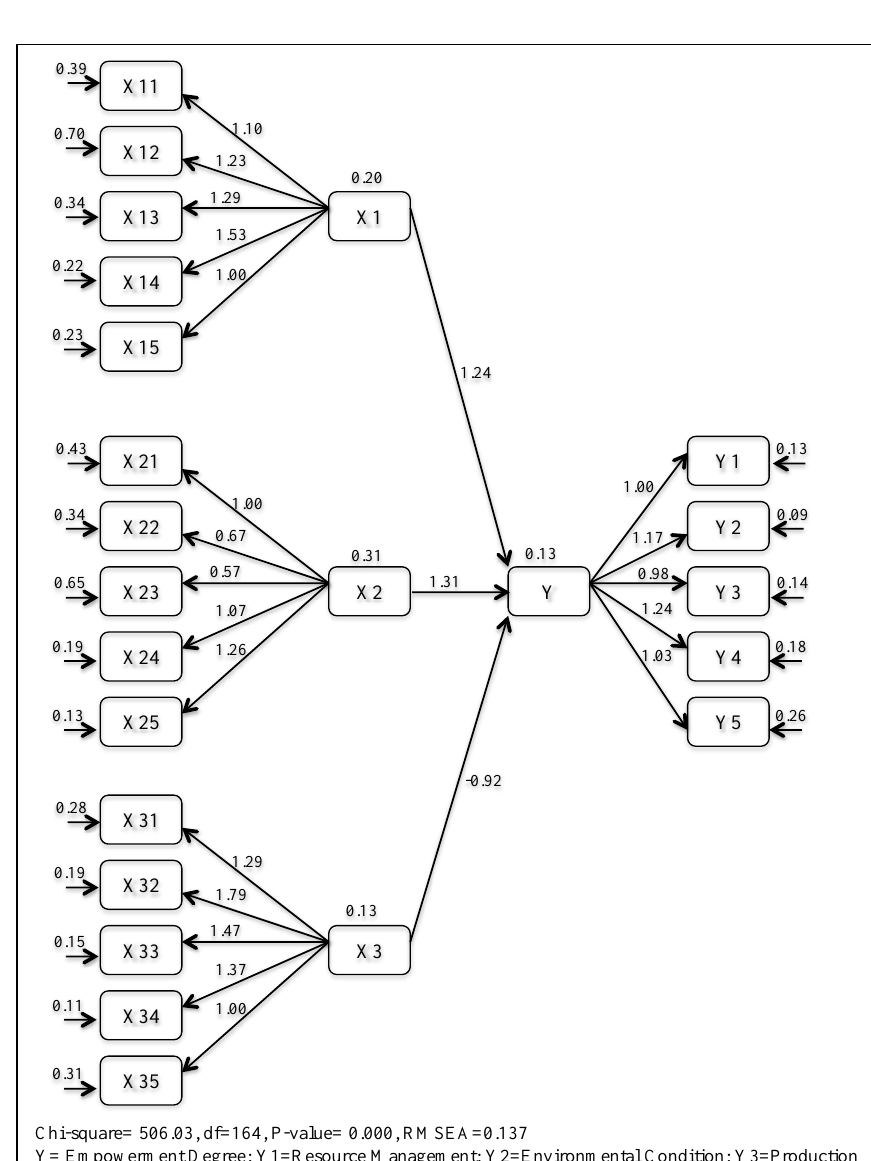
Figure 3. Structural equation model (SEM) constructed to quantify the relationships between the factors (X1–3) contributing to the empowerment level (Y) of the local community. Numbers alongside the arrows are the factor loadings, which indicate the correlation between factors